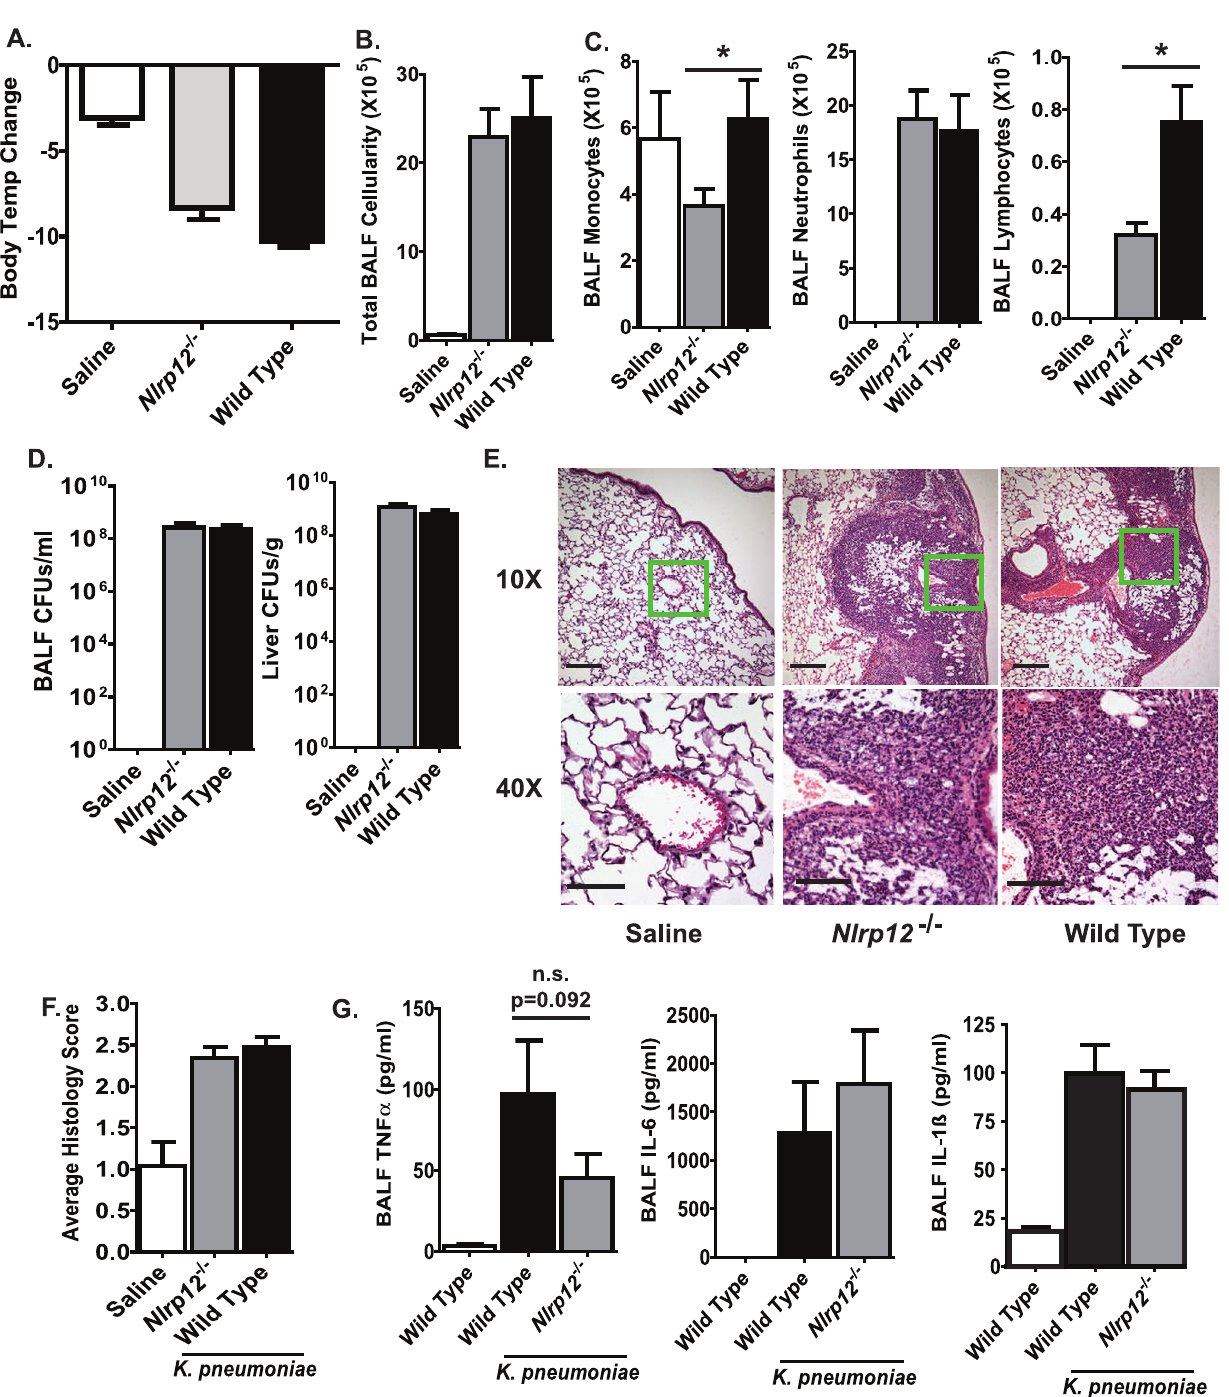
Figure 3. The host innate immune response to Klebsiellapneumoniae infection in Nlrp12 2 / 2 mice. A) Body temperature was monitored daily to assess morbidity. K.pneumoniae infection induced a significant decrease in body temperature in both Nlrp12 2 / 2 and wild type mice. B) The lungs were lavaged with HBSS and total BALF cellularity was determined. C) No significant differences in were observed in the BALF neutrophil populations between Nlrp12 2 / 2 and wild type mice. However, a significant decrease in the number of monocytes (p=0.042) and lymphocytes (p=0.032) were observed in the BALF from the Nlrp12 2 / 2 mice compared to the wild type. *P , 0.05. D) No differences in bacterial burden were found between the BALF and livers of Nlrp12 2 / 2 and wild type animals. E) Histopathology revealed a significant amount of alveolar occlusion following K. pneumoniae infection in both Nlrp12 2 / 2 and wild type mice. The magnification bar at 10 6 =10 m M and 40 6 =5 m M. F) Histology scoring confirmed that no significant differences were identified between the Nlrp12 2 / 2 and wild type mice. G) A significant increase in TNF a , IL-6 and IL-1 b was observed in the BALF from all K. pneumoniae challenged animals. Saline, n=3; Nlrp12 2 / 2 , n=13; Wild Type, n=15. Experiments were repeated 3 separate times with a minimum of 7 K. pneumoniae infected Nlrp12 2 / 2 and 7 wild type mice in each group. n.s.=not significant; p=0.0917.